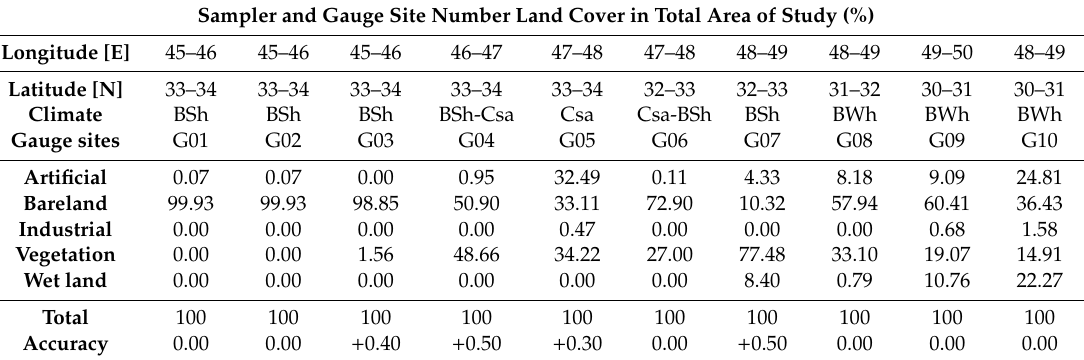
Table 4. Land Cover in the Study